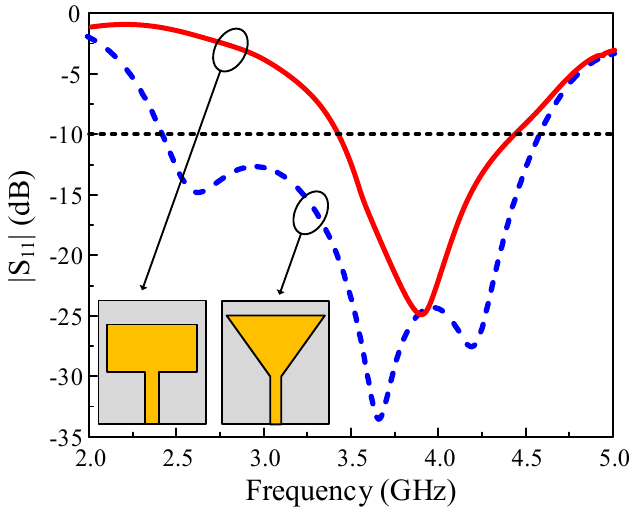
Figure 2. S 11 for rectangular shape monopole with and without truncated corners.